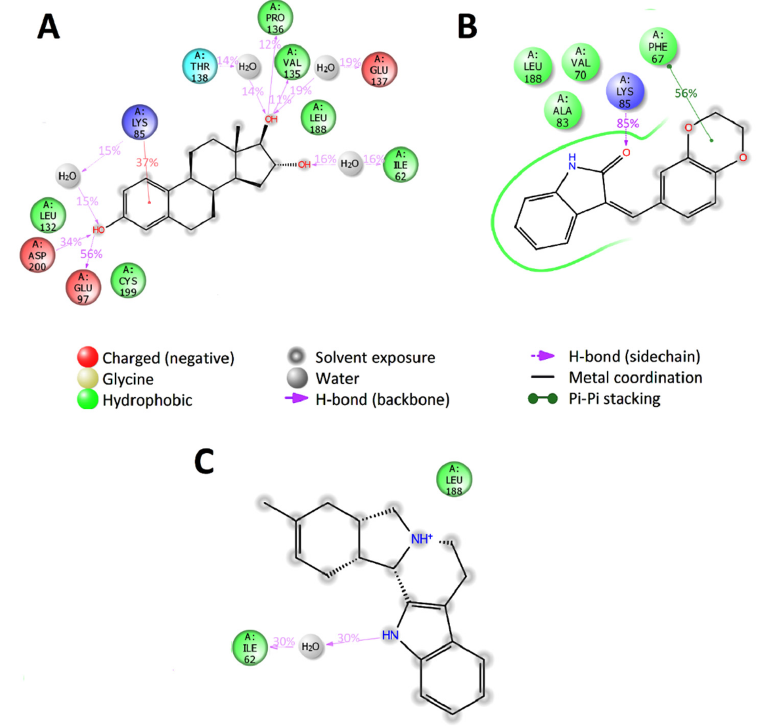
Figure 8. 2D summary diagram of molecular dynamics calculated contacts between GSK3 β and small-molecule ligands ( A ) ZINC3977996, ( B ) ZINC1034491 and ( C ) ZINC4027357. Interactions that occur more than 10% of the simulation time are shown.